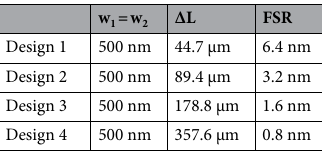
Table 1. LT-aMZI designs dimensions and FSR.